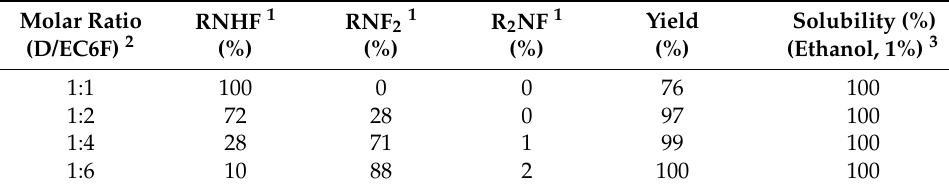
Table 1. Synthesis of fluorinated diethylenetriamine